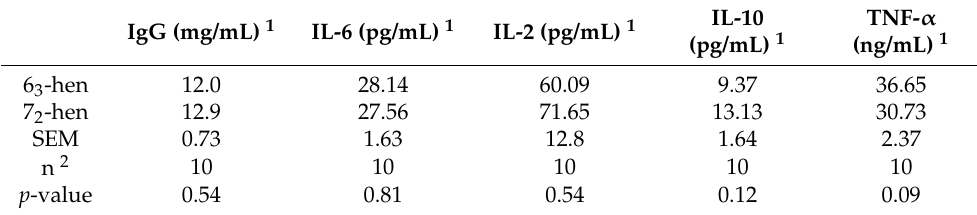
Table 2. Peripheral immunoglobulin G and cytokine levels between two diversely selected chicken lines.